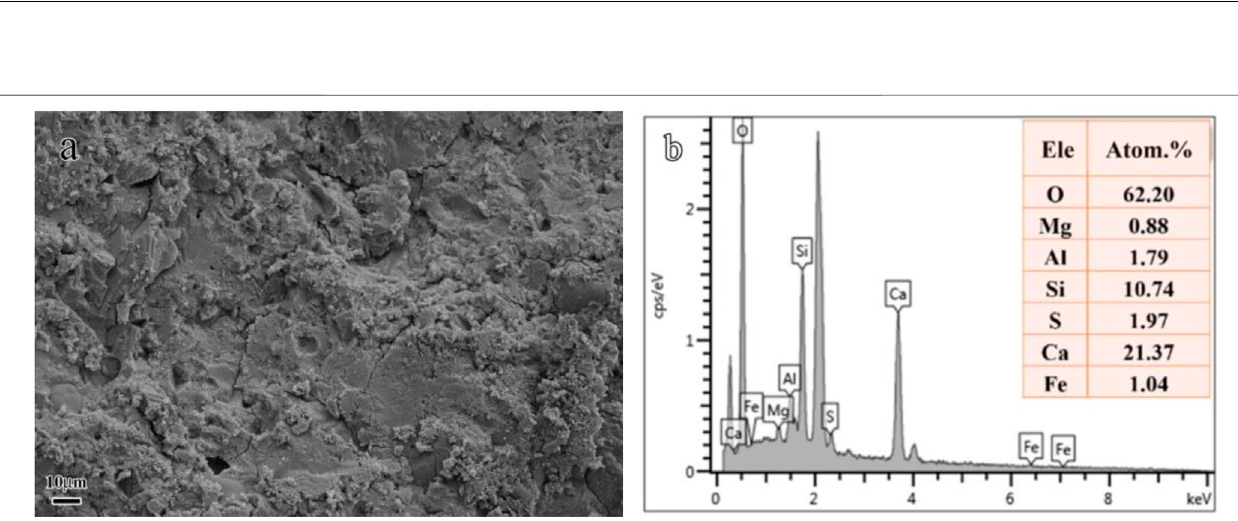
Frontiers in Materials |